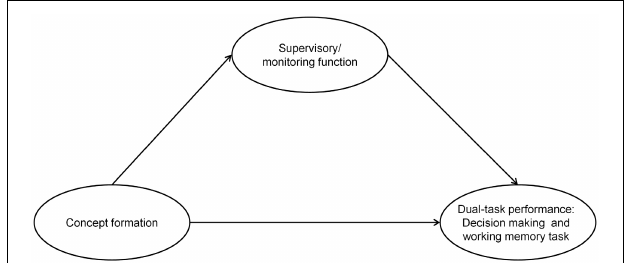
FIGURE 1 | The theoretical mediation model. It displays the possible mediation effect of the latent dimension supervisory/monitoring function on the relationship between concept formation and the simultaneous performance of decision-making task and working memory task. The arrows represent the assumed direction of the influence of the different